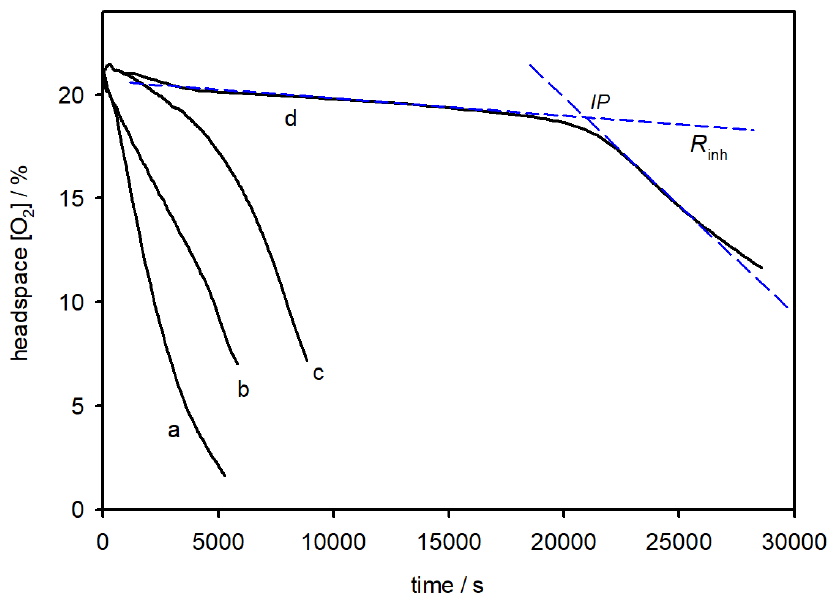
Figure 1. O 2 consumption during the autoxidation of SSO at 130 °C without antioxidants ( a ) or in the presence of 0.1% ( w / w ) of α -tocopherol ( b ), BHT ( c ) and TBHQ ( d ). In the presence of the antioxidants, the autoxidation onset of SSO was retarded for a variable period of time (induction period, IP ), after which the O 2 consumption was faster.